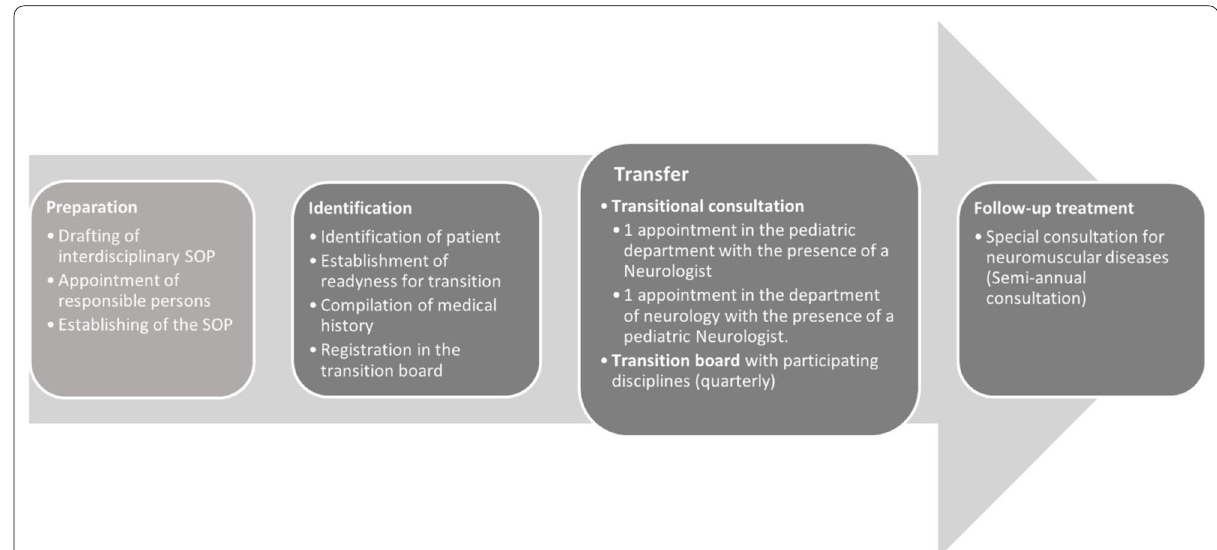
Fig. 1 Ilustration of the transition process for neuromuscular diseases within the framework of the "Essen Transition Model". In the course of the preparations, the process was coordinated across clinics and bindingly defined. The process is divided into three sections ("Identification", "Transfer" and "Follow‑up treatment"), within each of which specific tasks were